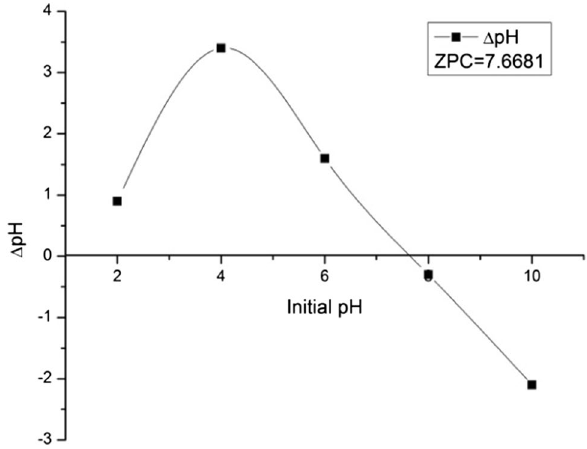
Fig. 1 P H ZPc of Cr(VI) by using chicken feather